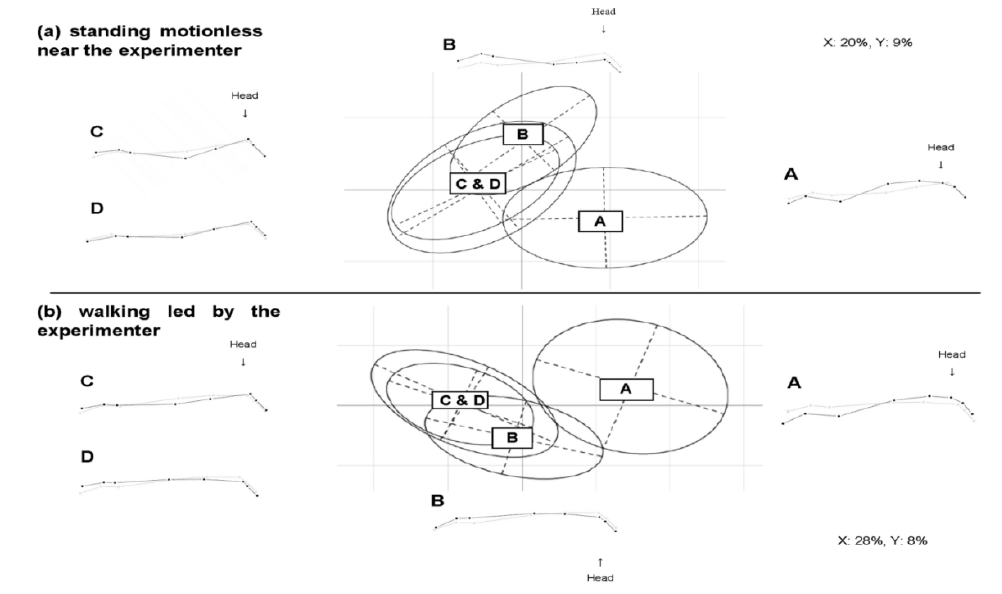
Figure 5. Postures in relation to behaviors at the group level. Lower case letters (a) and (b) refer to the parts of the figure and capital letters A, B, C, D to the riding schools. Principal component analysis (thin-plate spline (TPS) relative warp analysis, axes 2 and 3) based on TPS shape parameters and corresponding postures (black lines) as depicted by deformation grids. Barycentres of the observed postures (letters) and distribution values (showing the range of variation between observed postures for the behavior, represented on the graph by a circle around letters) are represented for a leisure horse, B, C and D horses from riding school B, riding school C and riding school D. Mean postures (representation extracted from TPS deformation grids) are represented for each population of horses (from A to D) while (a) standing motionless near the experimenter and (b) walking led by the experimenter. Axis 1 (not shown) explained respectively 50.80% of the postural variation when horses stood motionless and 49.70% when horses walked (variation occurred in neck height). For both behaviors considered, the inter-group postural variation occurred mainly in horses’ neck height and back roundness: leisure horses (A) had higher necks and back roundness than horses from riding schools (B, C and D). Distribution along axis 3 revealed that horses’ postures also differed among riding schools: horses from riding school B had on average more straight and flat posture than those from riding schools C and